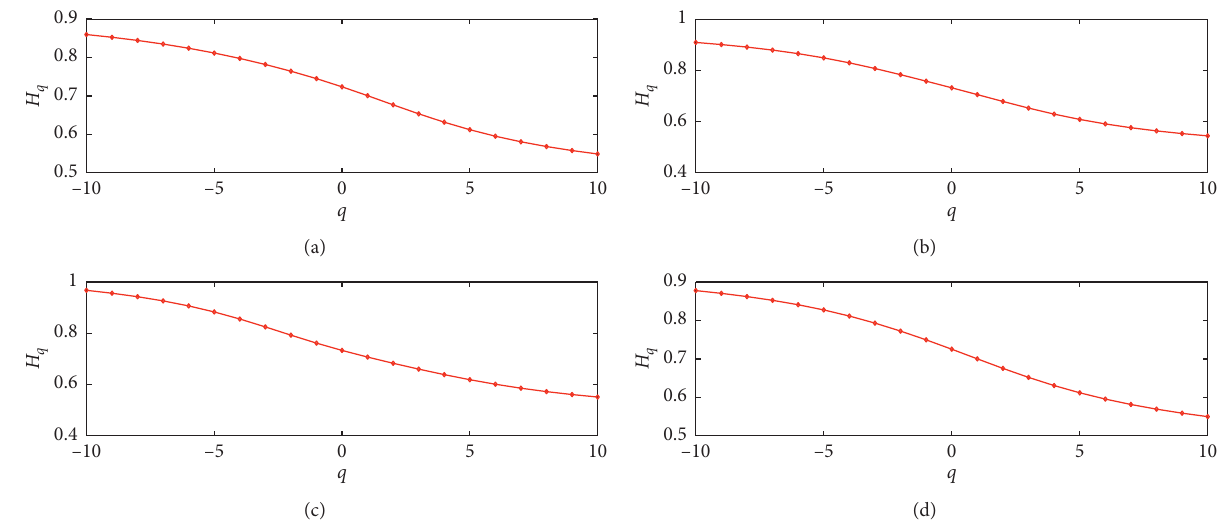
Figure 9: MF-DCCA scaling exponent for the market participation willingness and Chinese stock market volume. (a) SME-YSI. (b) SSE50- YSI. (c) CSI300-YSI. (d)